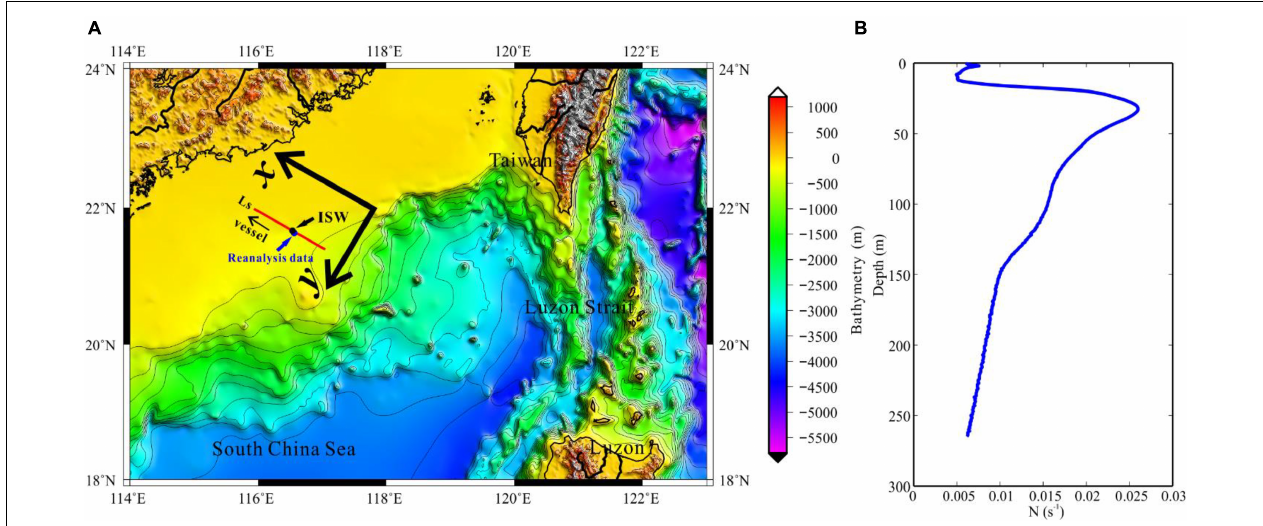
FIGURE 1 | (A) The observation location and bathymetry. The red line is location of seismic section (Ls). The black dot is the location of the internal solitary wave in seismic section. The blue dot is the location of reanalysis data. The arrow indicates the direction of vessel. (B) The buoyancy frequency estimated from reanalysis